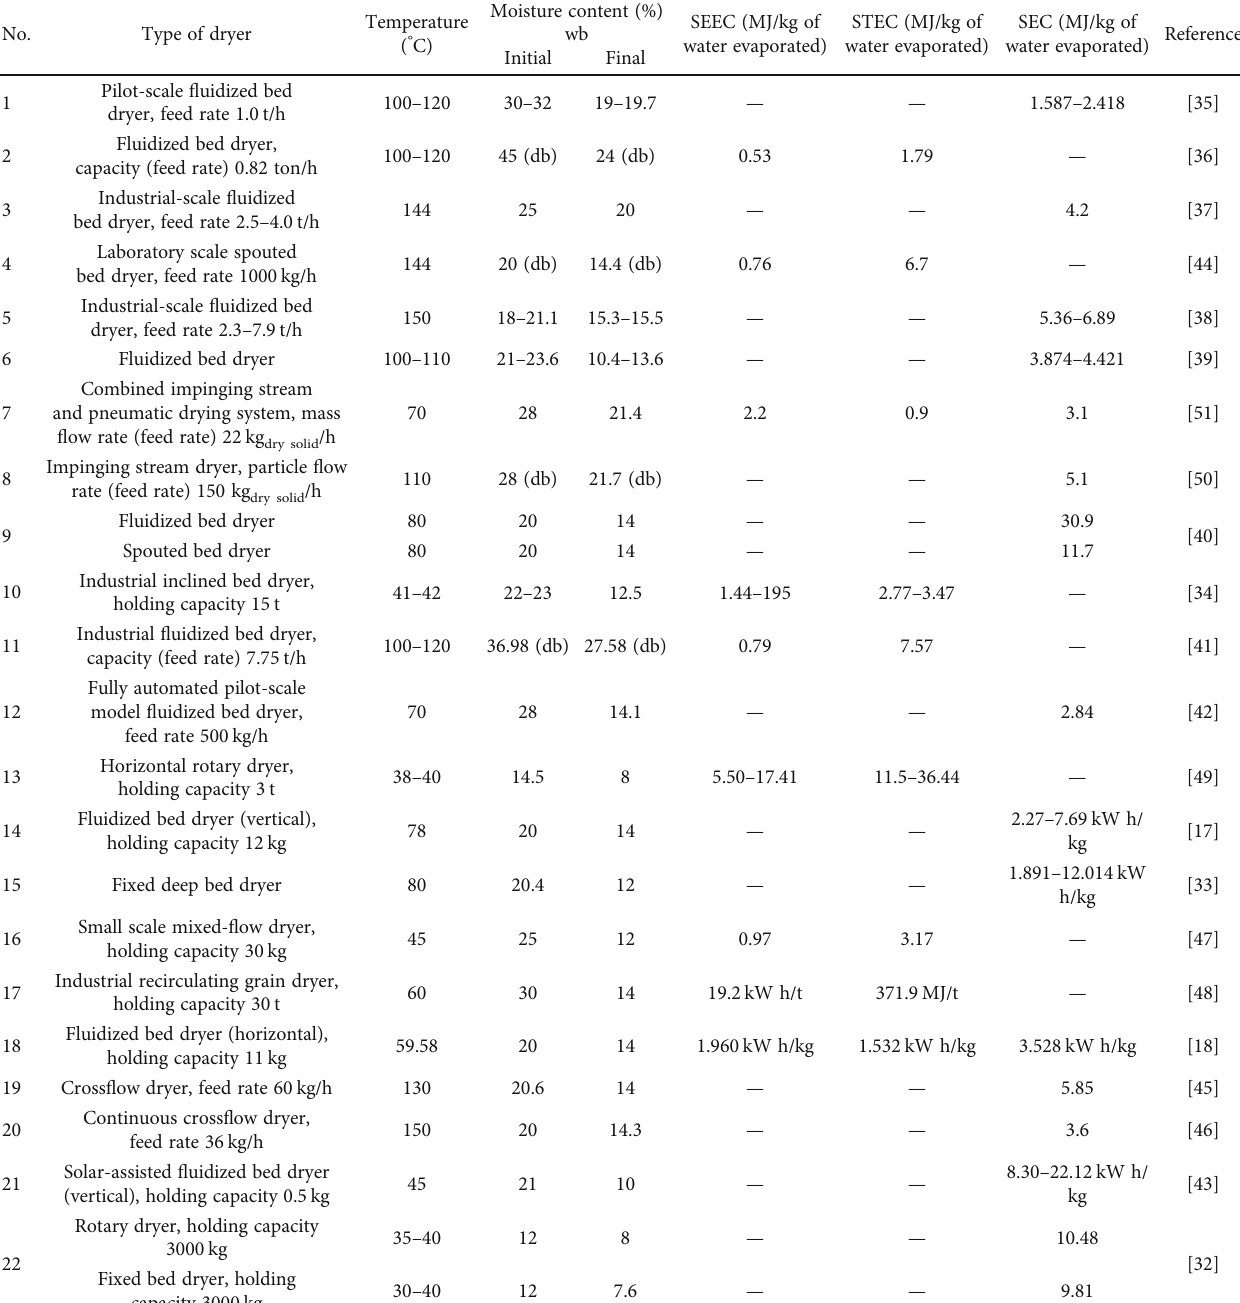
Table 1: Summary of energy consumption of various types of dryers for paddy drying (from the literature). No.